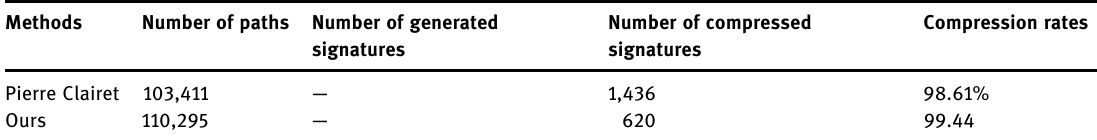
Table 4: Results of the two methods in terms of Performance ( Graph compression )